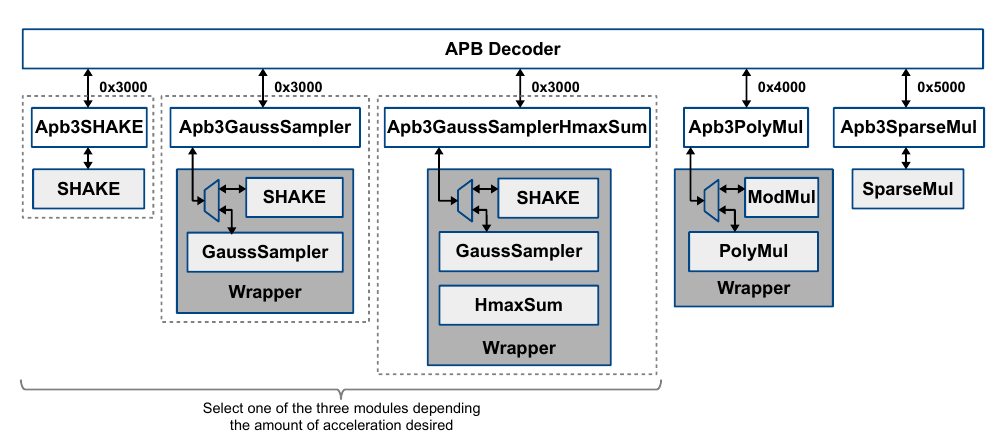
Figure 8: Detailed diagram of the connections between the APB Decoder, APB bridge modules and hardware accelerators. Dotted squares all contain a SHAKE module and thus one peripheral from these three can be chosen depending on user’s requirements when a SHAKE accelerator is needed in the